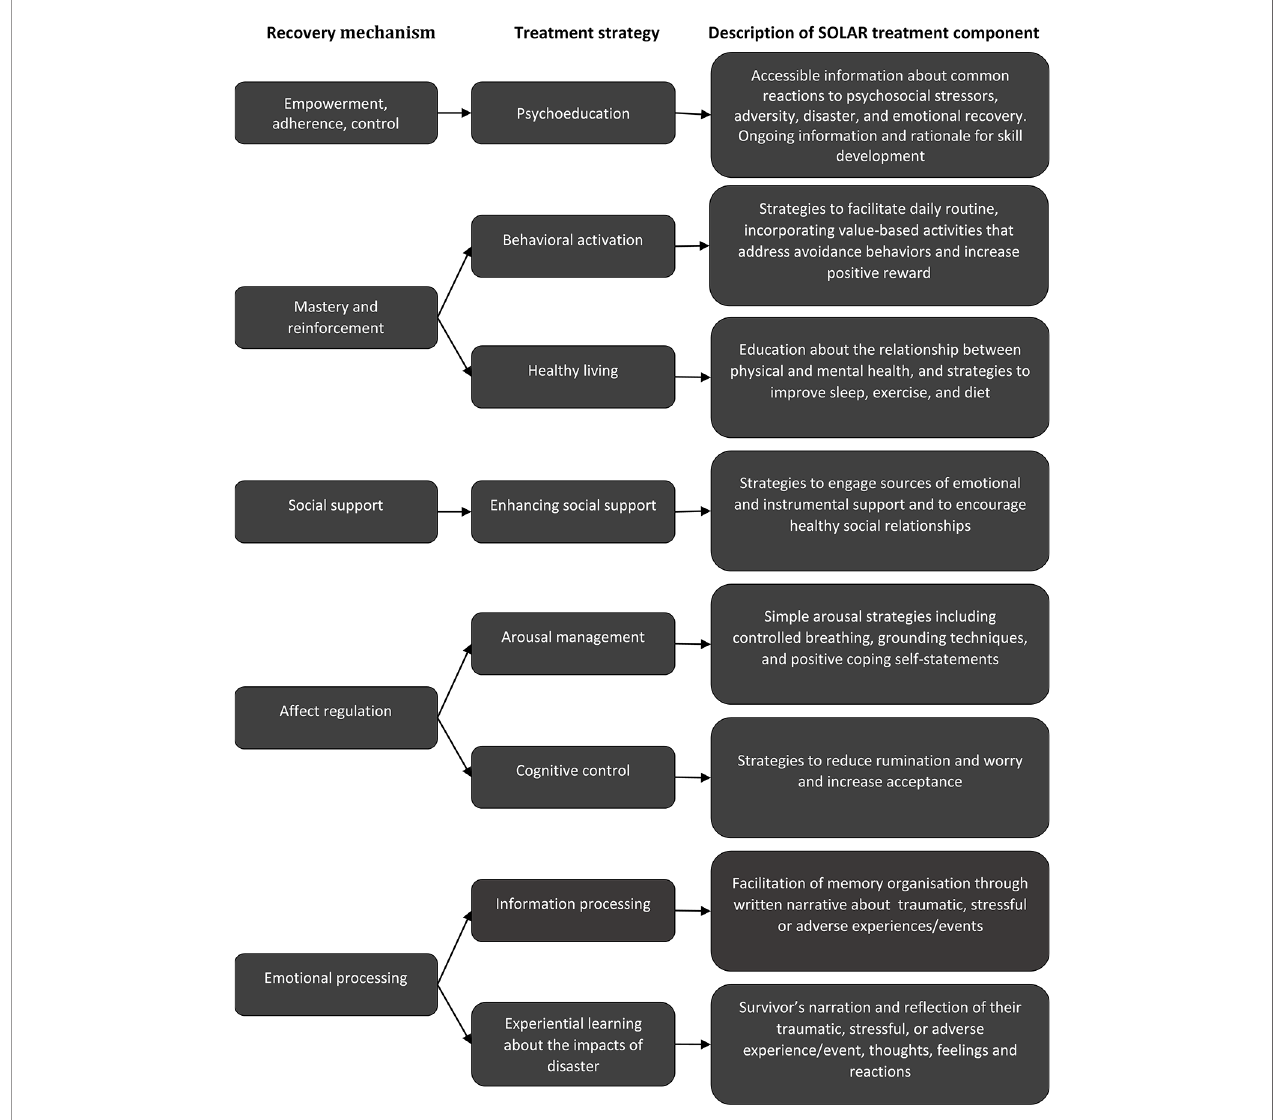
FIGURE 1 | The SOLAR program: Mechanisms of post-trauma and mental health recovery, relevant treatment strategies, and summary description of SOLAR treatment